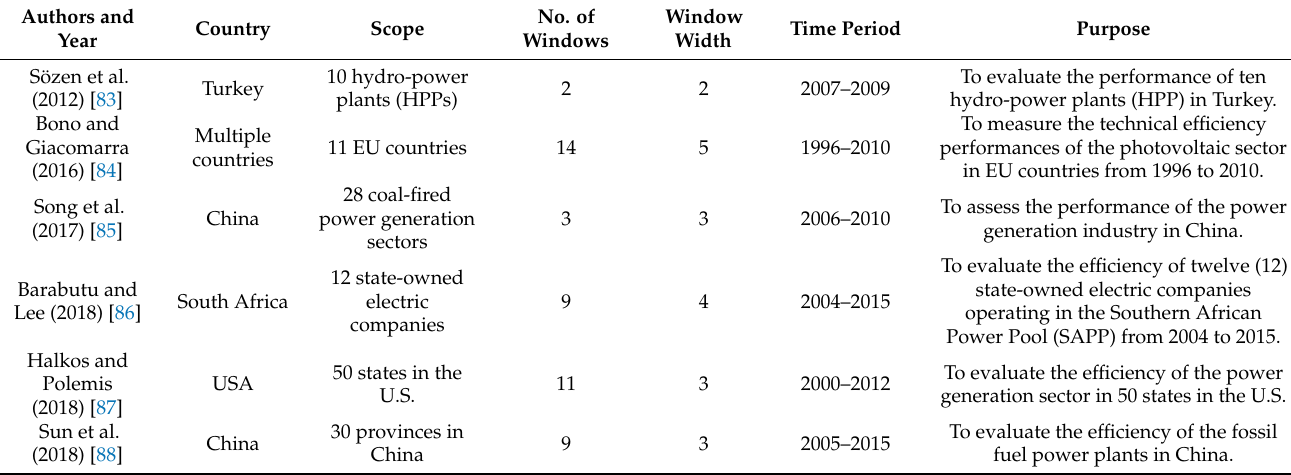
Table 9. Articles classified under the power